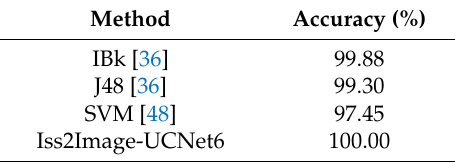
Table 6. Average accuracy comparison between Iss2Image-UCNet6, and existing methods on the MobiAct dataset.